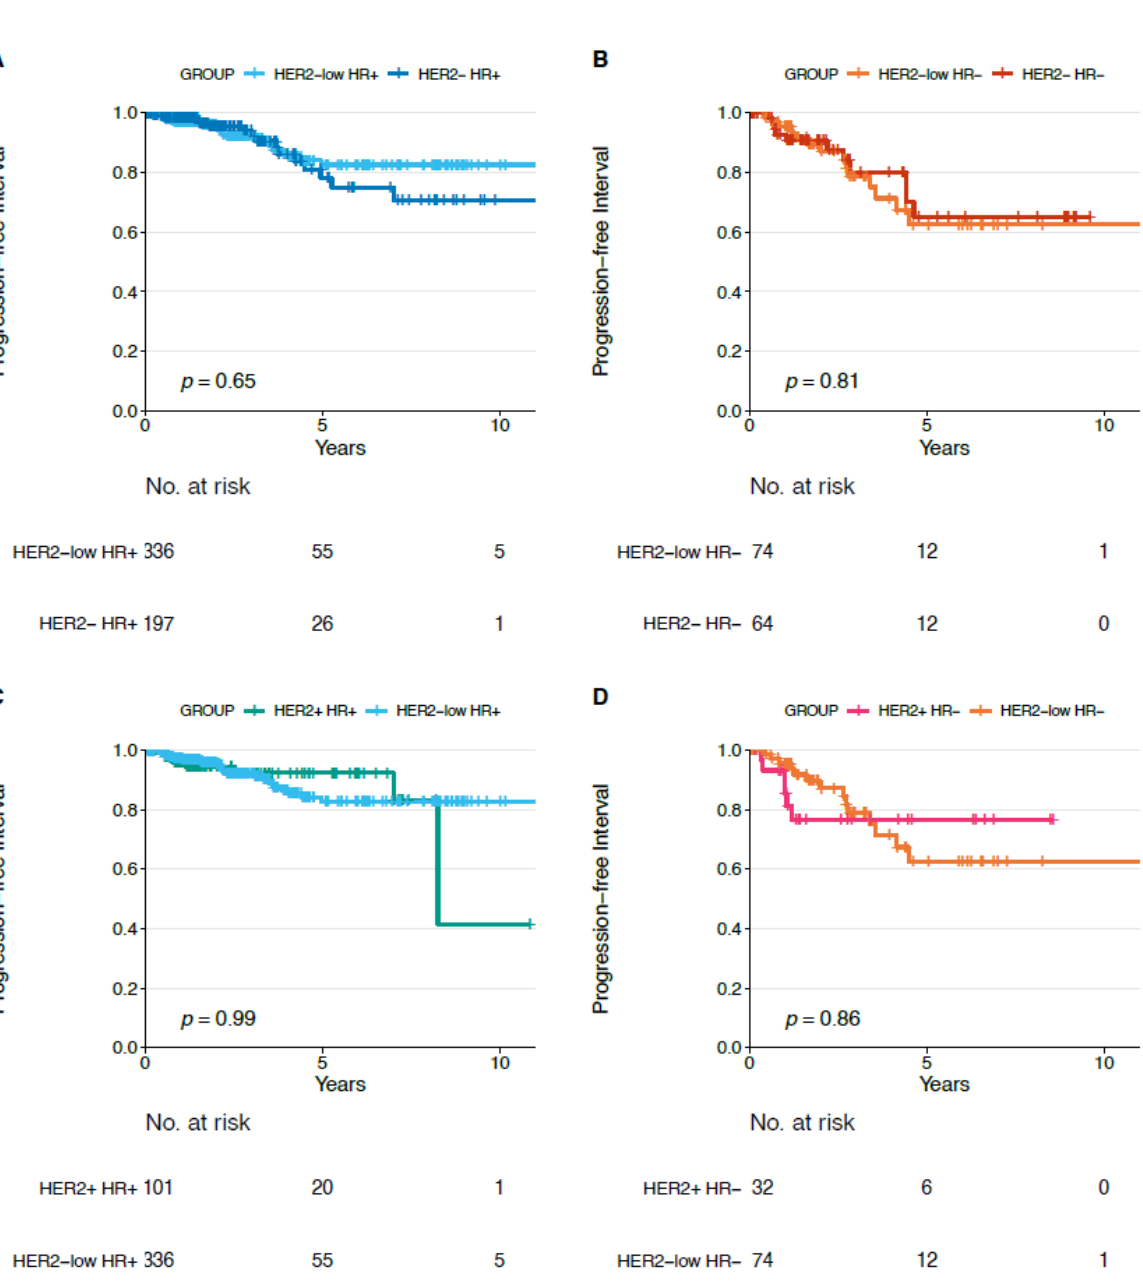
Figure 5. Progression-free interval in HER2-low/HR+ versus HER2−/HR+ ( A ), in HER2-low/HR− versus HER2−/HR− ( B ), in HER2-low/HR+ versus HER2+/HR+ ( C ) and in HER2-low/HR− versus HER2+/HR− ( D ) tumors. Abbreviations: HR: hormone receptor.